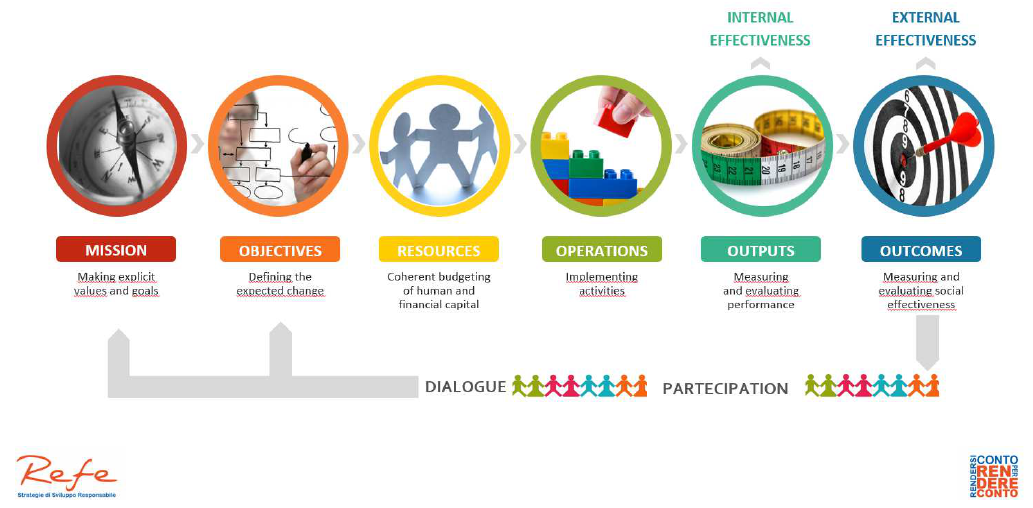
Figure 1: Conceptual Framework for Rebuilding the